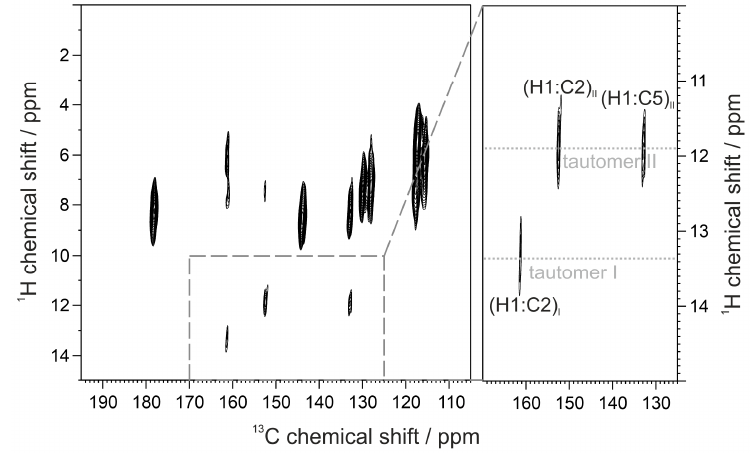
Figure 5. 1 H- 13 C CP-MAS correlation spectrum of compound 2d . Right block shows magnified view of the selected area in the correlation spectrum.